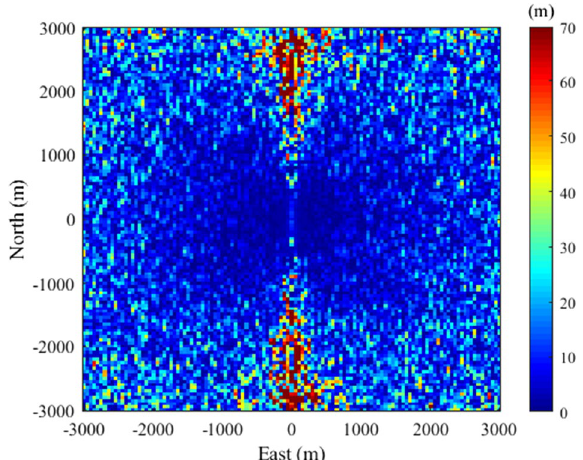
Fig. 4 The positioning error of ASBL